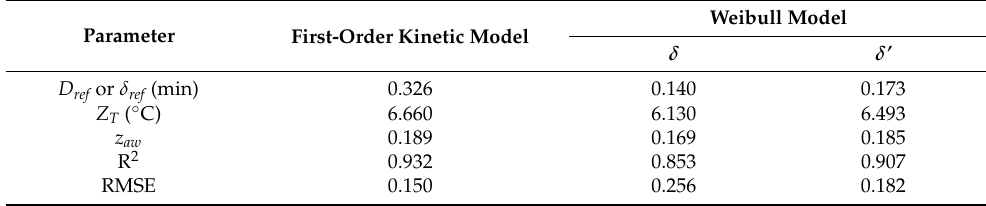
Table 4. Calculated D ref , z aw , and z T values of Mafart’s modified Bigelow model at 65 ◦ C for the thermal inactivation of Aspergillus inoculated into the almond